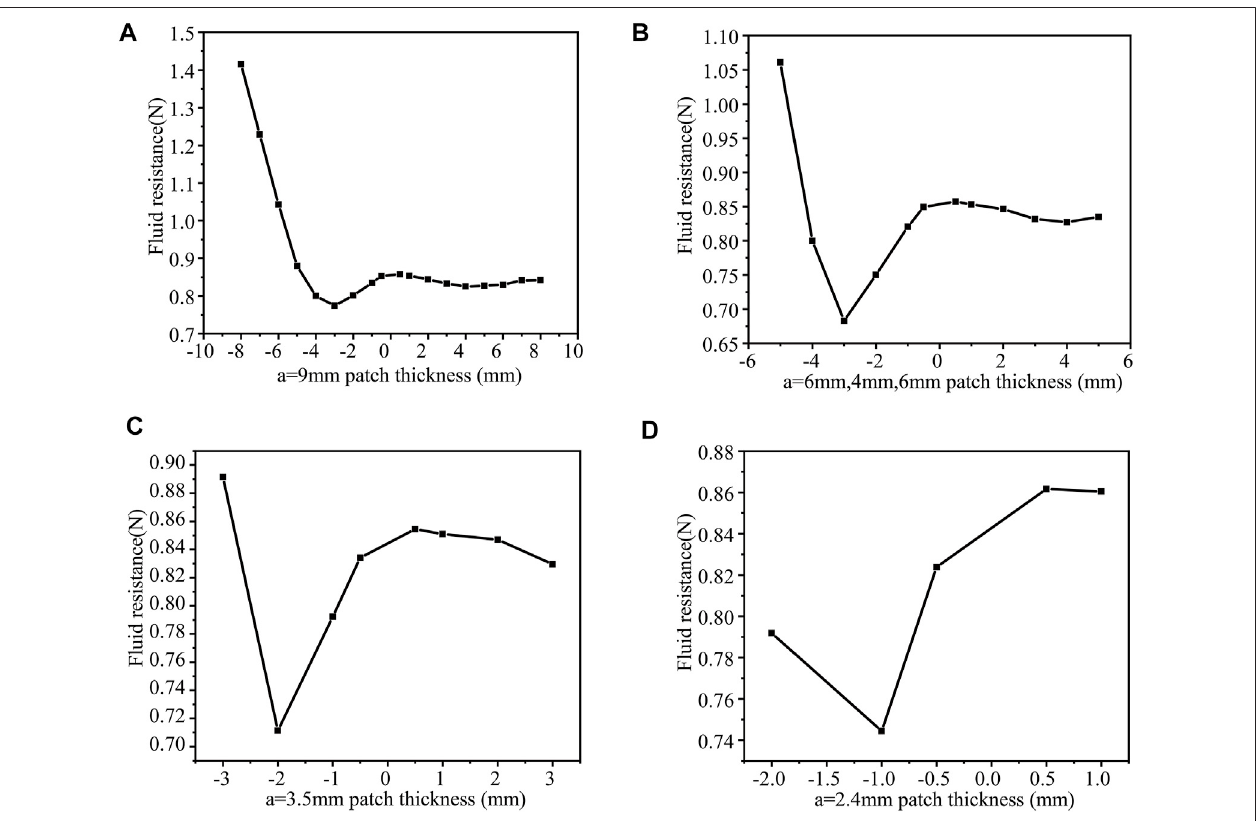
FIGURE10| b=2 mm,thedragforceunderdifferentpatchnumbersanddifferentthicknesspatchesinthecaseof (A) a=9mm (B) a=6mm,4mm,6mm (C) a= 3.5 mm (D) 2.4